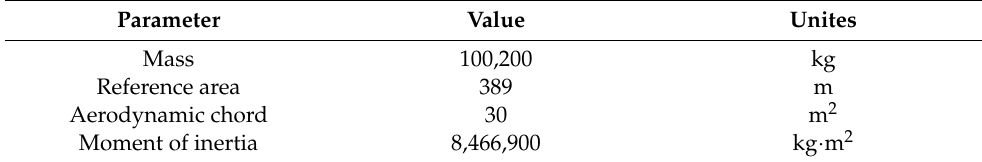
Table 1. Parameters of